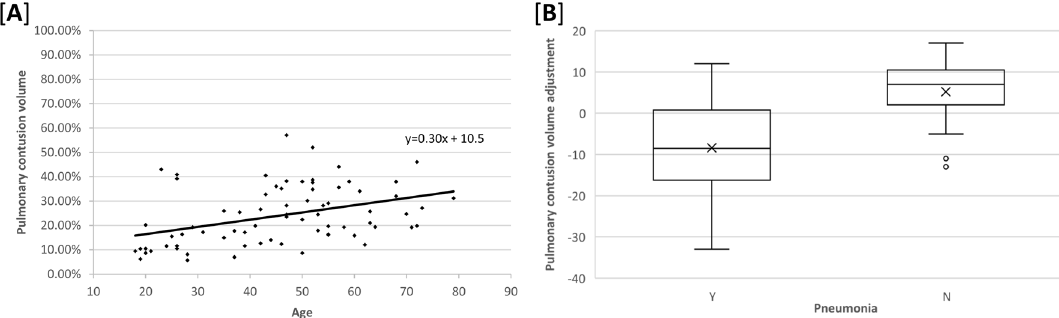
Figure 3. Age adjustment for pneumonia incidence according to pulmonary contusion volume. ( A ) Pneumonia incidence according to age has a regressive relationship. ( B ) In order to adjust for age, a simple linear regression is used to calculate the residual, and then the mean and standard deviation were calculated, and there was still a statistically significant difference between the moderate and severe groups (5.21 ± 7.12 and − 8.37 ± 11.21, respectively) (p < 0.001).